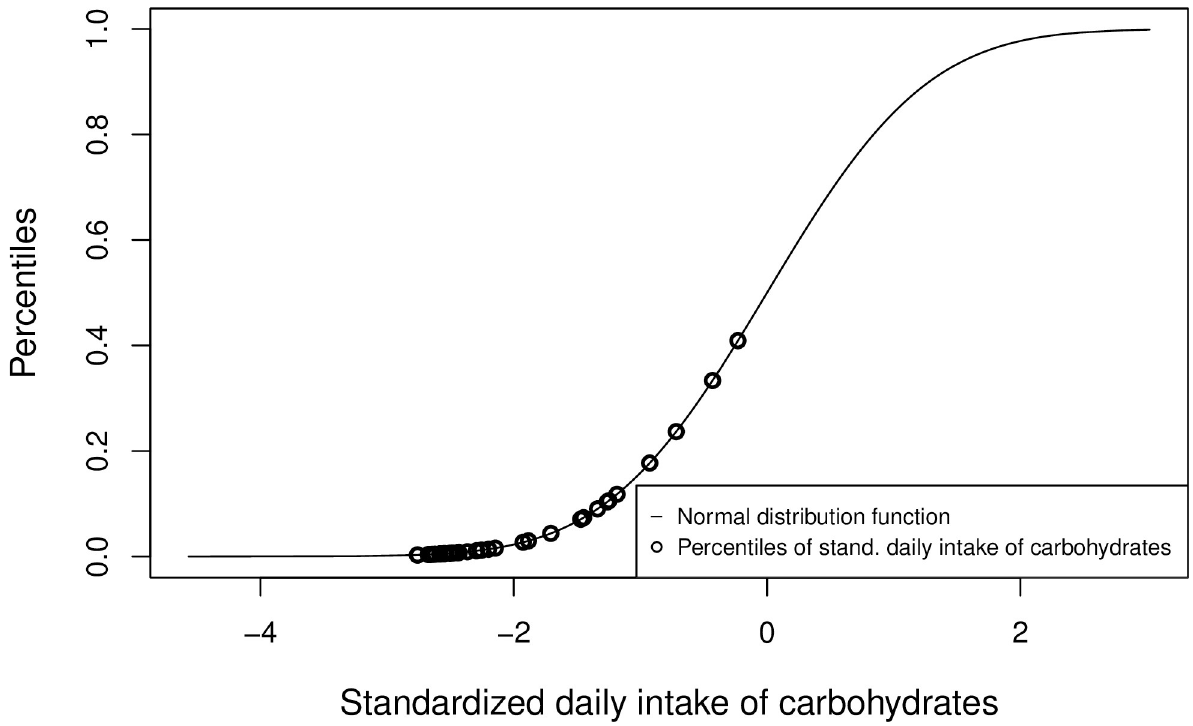
Fig 1. Carbohydrate Z-scores and their corresponding percentiles after transformation using the standard normal distribution function. Due to the usage of the standard normal distribution function by Shivappa et al. [17] to transform daily food parameter Z-scores (here carbohydrates of a simulated dataset of n = 32; Table 1) into percentiles, the resulting percentile scores are only scaled between [0.003, 0.409] and do not distribute across the entire unit interval.